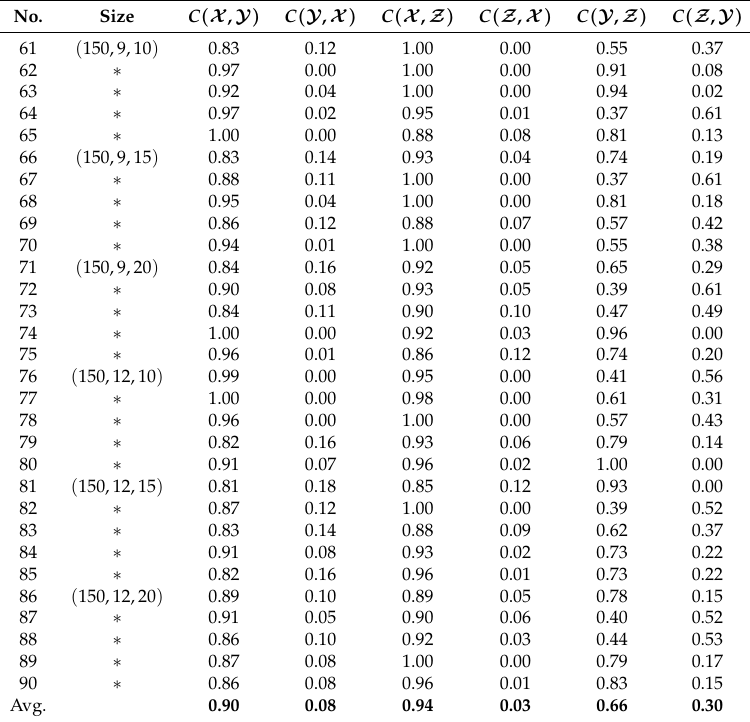
Table 10. Coverage metrics for comparing the algorithms on the test instances with 150 cars. No.